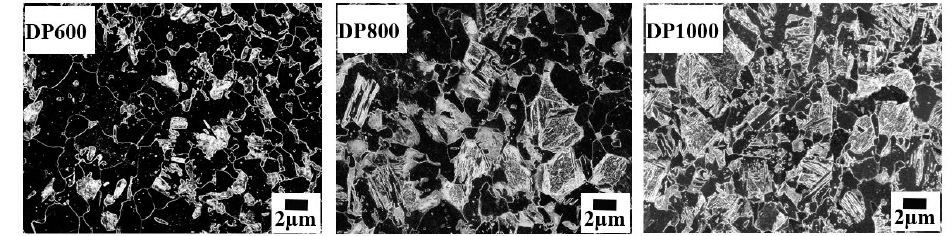
Figure 1. SEM micrograph of commercial DP600, DP800 and DP1000 steel samples (in InLens mode with 5 kV). Table 1. Summary of the ferrite fraction, hardness and grain size of commercial DP steels, HR = Hot-rolled, CR = Cold- rolled, Gl = Galvanised, mm = sample thickness.